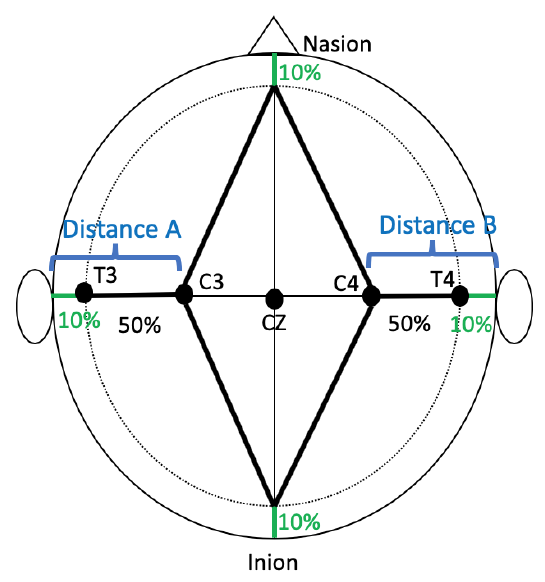
Figure 1. Motor cortex localization using the 10/20 Electroencephalogram (EEG) System. Traditional, manual 10/20 EEG measurements to localize the motor cortex of the left hemisphere (C3) and right hemisphere (C4) based on structural landmarks of the head. Landmarks are marked including the nasion, inion, and preauricular notches on the head to guide measurements. Percentages represent the percentage of the distance from the landmark to the EEG location. The measurement of interest is Distance A, from the preauricular notch to C3, and Distance B, from the preauricular notch to C4. 10/20 EEG: 10/20 International Electroencephalogram Coordinate System, C: Central, CZ: Central Zero; T: Temporal.